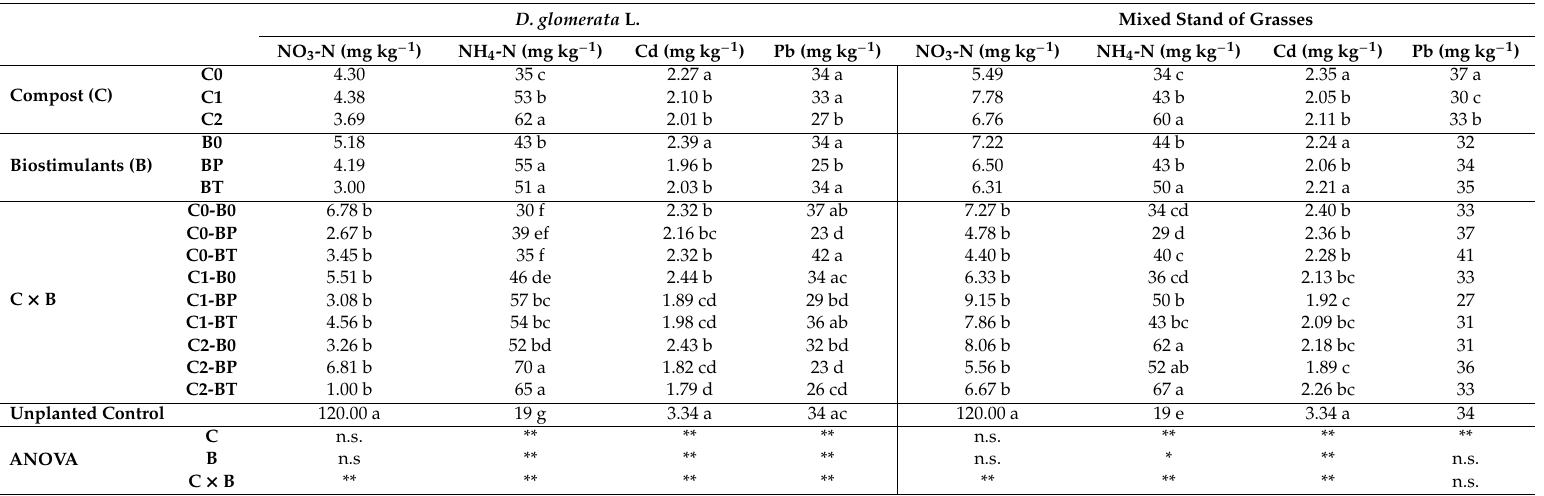
Table 2. Nitrogen concentrations (NH 4 -N and NO 3 -N) and NH 4 NO 3 -extractable Cd and Pb concentrations in soil at the end of the experiment. C0 = no compost, C1 = 0.7%, C2 = 1.4%; B0 = no biostimulants, BP = Panoramix, BT = Trianum-P; Unplanted control = non-planted and untreated soil. Mean values within columns and factor with the same letter do not di ff er according to the LSD test ( p < 0.05). * p < 0.05; ** p < 0.01; n.s., not significant. D. glomerata